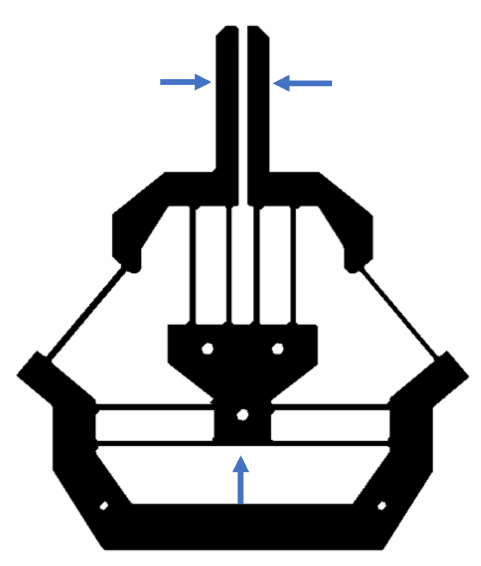
Figure 2. The first version of compliant gripper.